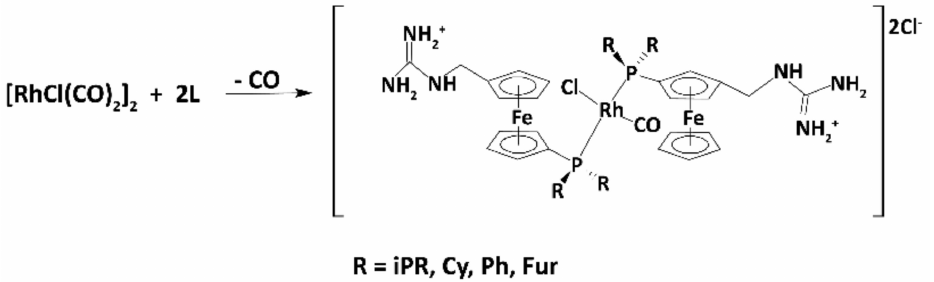
Scheme 7. Reaction scheme for the synthesis of Rh(I) complexes bearing phosphanylferrocene ligands with cationic guanidinium tags and varied phosphane